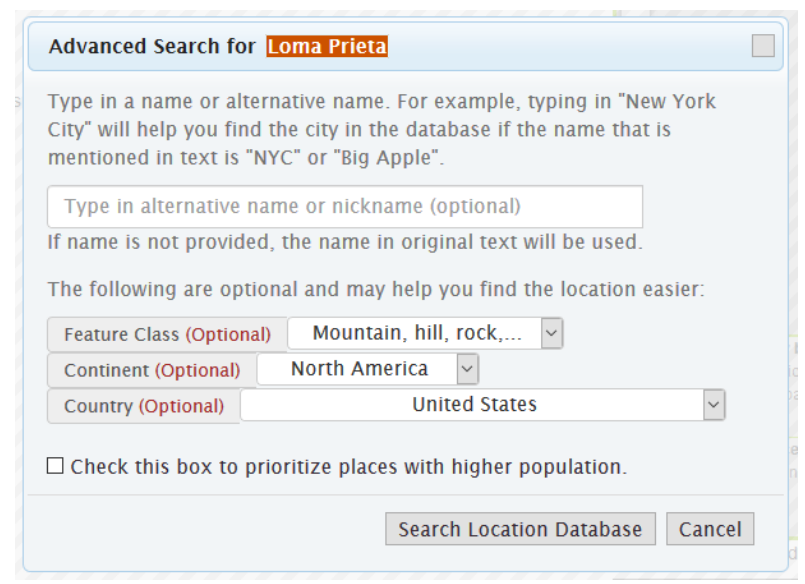
Figure 3. Advanced search for looking up places whose name in the text is not sufficient for the system to retrieve a list of relevant toponyms.